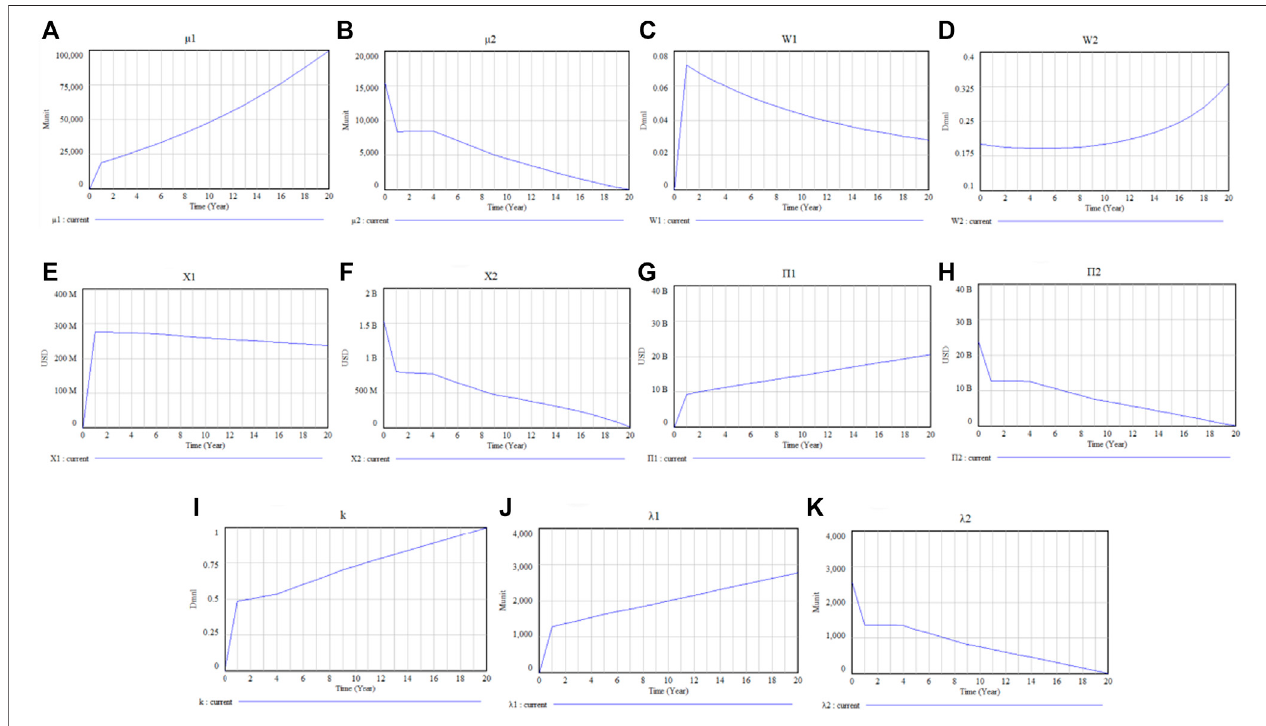
FIGURE 9 | Dynamic relationship between EVR and transition ratio: (A) The trend of μ 1; (B) The trend of μ 2; (C) The change of W1; (D) The change of W2; (E) The change of X1; (F) The change of X2; (G) The change of Π 1; (H) The change of Π 2; (I) The change of k; (J) The change of λ 1; (K) The change of λ 2.